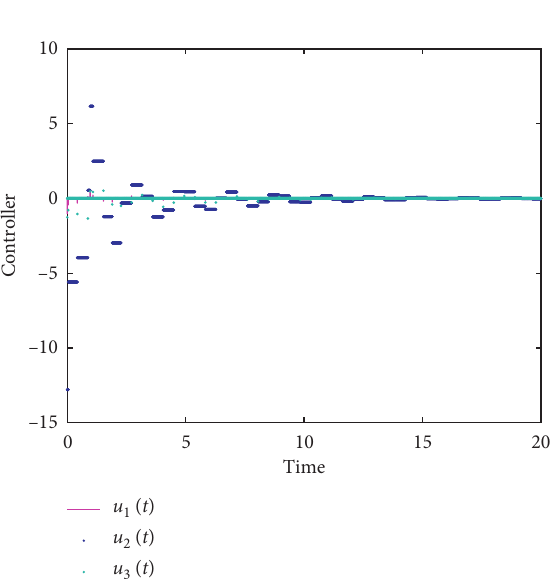
Figure 7: Responses of e